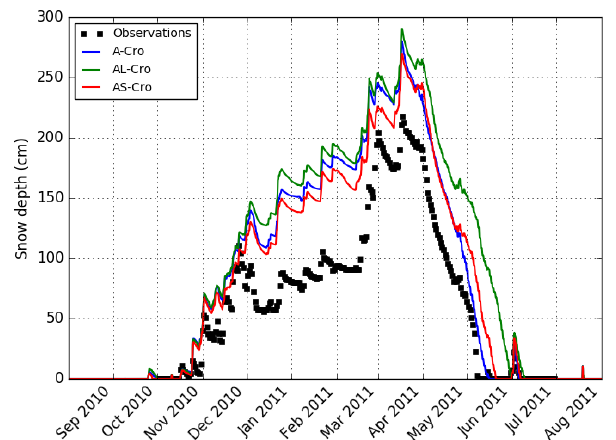
Figure 8. Snow depth evolution at Albeille station (2195m, French Pyrenees) during winter 2010–2011: observations in black, A-Cro simulation in blue, AL-Cro in green, AS-Cro in red.